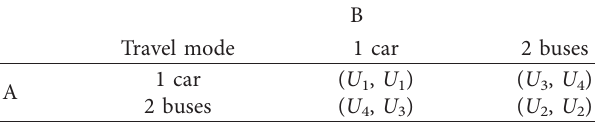
Table 2: The implementation of the limit.